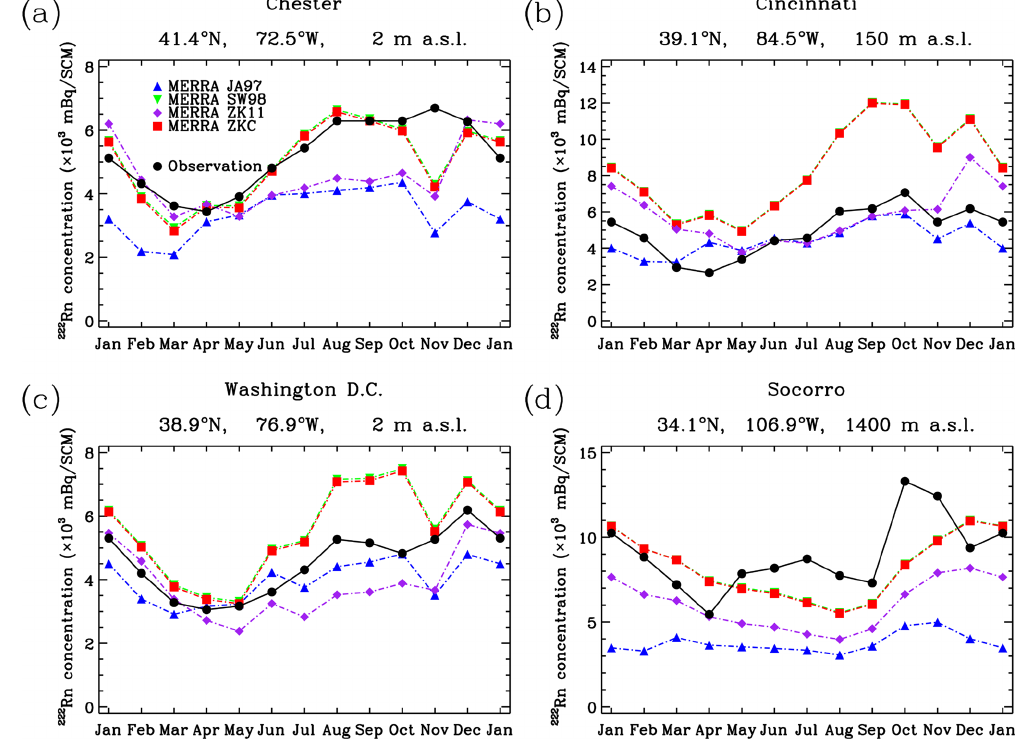
Figure 10. Same as Fig. 8 but for North